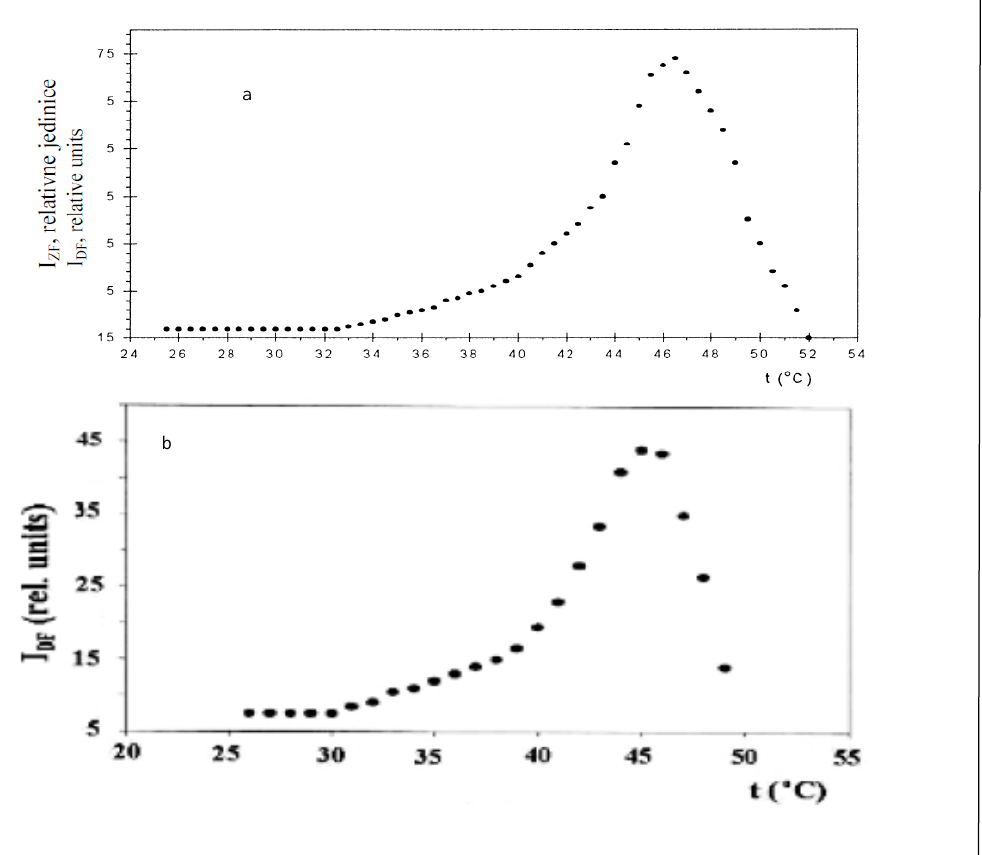
Figure 4 – Changes in the intensity of the delayed chlorophyll fluorescence (I DF ) of the thermal processes depending on temperature in the thylakoid membrane and chloroplasts of the intact above-ear leaf of the new air dried maize inbred lines ZPPL 146 (a) and ZPPL 159